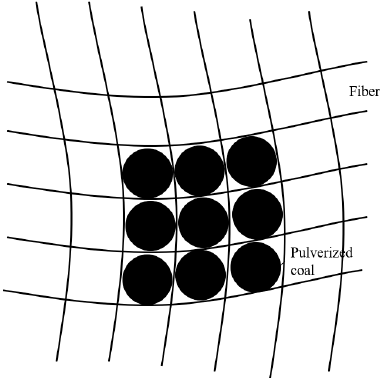
Figure 2. The schematic diagram of a fiber barrier resisting pulverized coal.